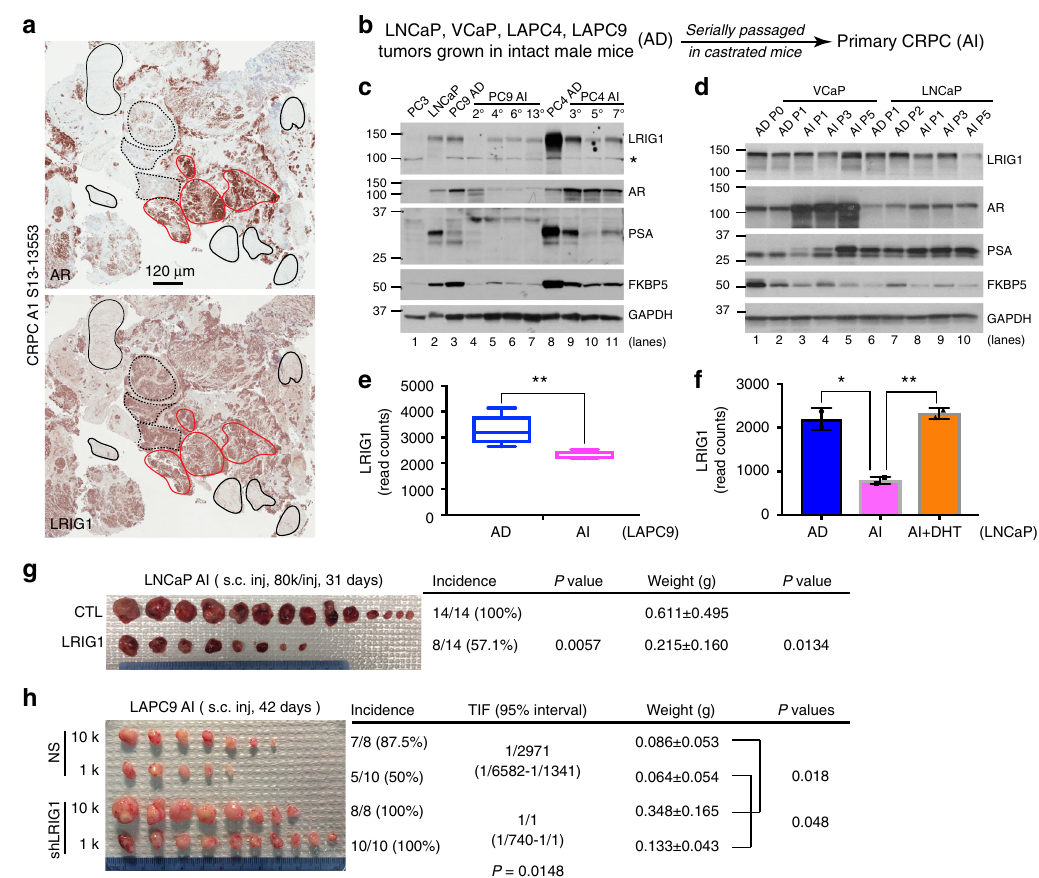
Fig. 5 Expression and tumor-suppressive functions of LRIG1 in CRPC. a Heterogeneous LRIG1 expression and discordant AR/LRIG1 expression patterns in CRPC. Contiguous WM sections from a CRPC (case# indicated on left) were stained for (top) AR (mouse mAb from Santa Cruz clone 441; 1:100 dilution)) and (bottom) LRIG1 (Sigma, 1:100 dilution). AR + /hi /LRIG1 hi , AR − /lo /LRIG1 lo , and AR − /lo /LRIG1 hi areas are marked by solid red, solid black, and dashed black circles, respectively (note that the AR IHC image represented part of the image in Fig. 1c of ref. 51 ). b Experimental scheme to generate castration- resistant (androgen-independent [AI]) xenograft tumors from the corresponding androgen-dependent (AD; androgen-sensitive) parent tumors (see Methods). c , d Reduced but persistent LRIG1 expression in experimental CRPC. Whole lysate of AD and AI tumors at the indicated passages (P) was used in WB for molecules indicated. The asterick in c represents a non-speci fi c band detected by Sigma anti-LRIG1 antibody. e , f Reduced LRIG1 mRNA levels in LAPC9 ( e ) and LNCaP ( f ) AI tumors. Presented are the raw read counts of LRIG1 mRNA fragments in RNA-seq of AD/AI tumors ( n = 5 each; ref. 51 ). For the LNCaP model, a condition of “ AI + DHT ” was added. * P < 0.05; ** P < 0.01 (unpaired multiple t -test in GraphPad and statistical signi fi cance determined using the Holm-Sidak method). The centerlines in box plots e show the mean values, box edges are 25th and 75th percentiles and whiskers represent minimum and maximum values. g LRIG1 overexpression in LNCaP AI cells inhibits CRPC regeneration. LNCaP cells were freshly puri fi ed out from AI tumors and infected with control (CTL) or pLVX-LRIG1 (LRIG1) lentiviral vectors (MOI 5, 48 h), and subcutaneously (s.c) injected in castrated NSG mice. Tumor incidence, tumor weight, and P values are indicated. h Knocking down endogenous LRIG1 in LAPC9 AI cells promotes CRPC regeneration. LAPC9 AI cells were puri fi ed out from xenografts and infected with control (NS) or shLRIG1 vectors (MOI 10, 12 h), and s.c injected (at two cell doses) in castrated male NOD/SCID mice. Tumor incidence, TIF (tumor-initiating frequency), tumor weight, and P values are indicated. *Source data for Fig. 5c, d, g, h are provided as a Source Data fi